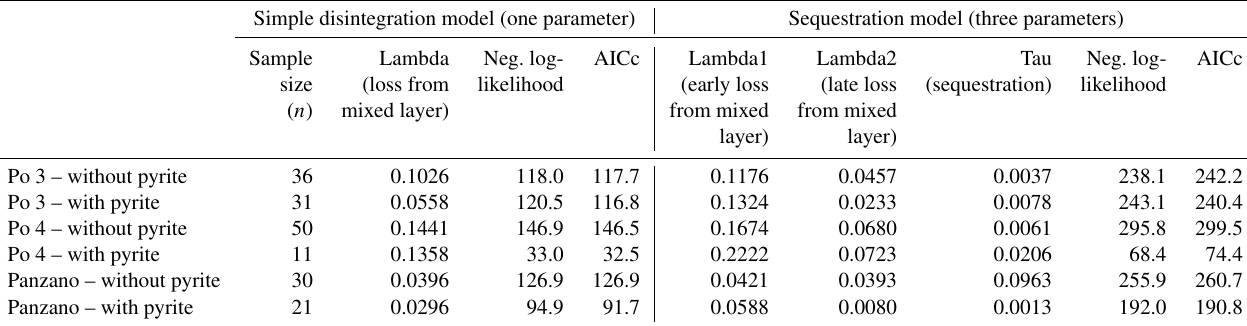
Table A1. The results of fitting age–frequency distributions (for valves with and without pyrite linings) from the mixed layer at three sites to a simple disintegration model (with temporally constant loss rate of V. gibba valves by disintegration and/or burial from the mixed layer; independent estimates of net sedimentation rates indicate that this parameter primarily corresponds to burial rate) and to a sequestration model with three parameters (per year). AICc – Akaike information criterion corrected for sample